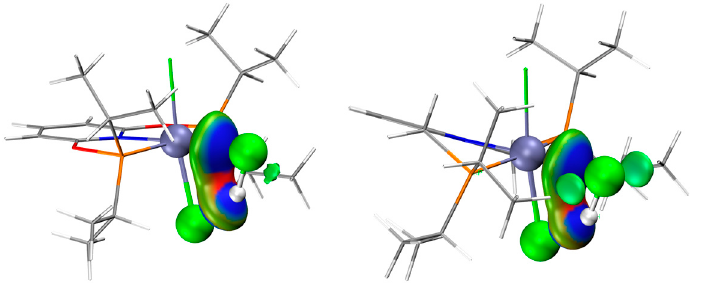
Figure 2. IGM analysis of HCl adsorbed by CAT − 1 ( left ) and CAT − 2 ( right ). Ball colors: green (Cl), gray (C), white (H), blue (N), red (O), brown (P), cyan (Ru). Blue surface represents larger gradient value.